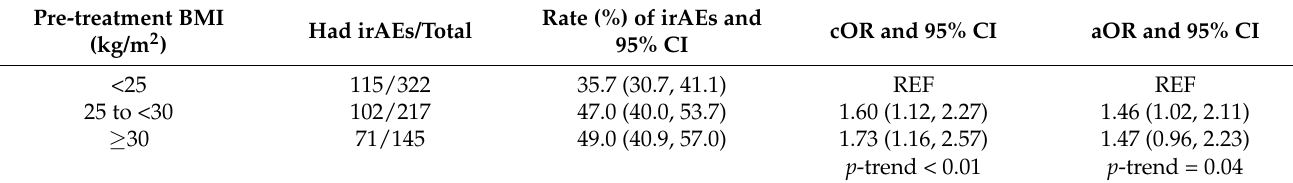
Table 2. Association between pre-treatment BMI with irAEs ( N =